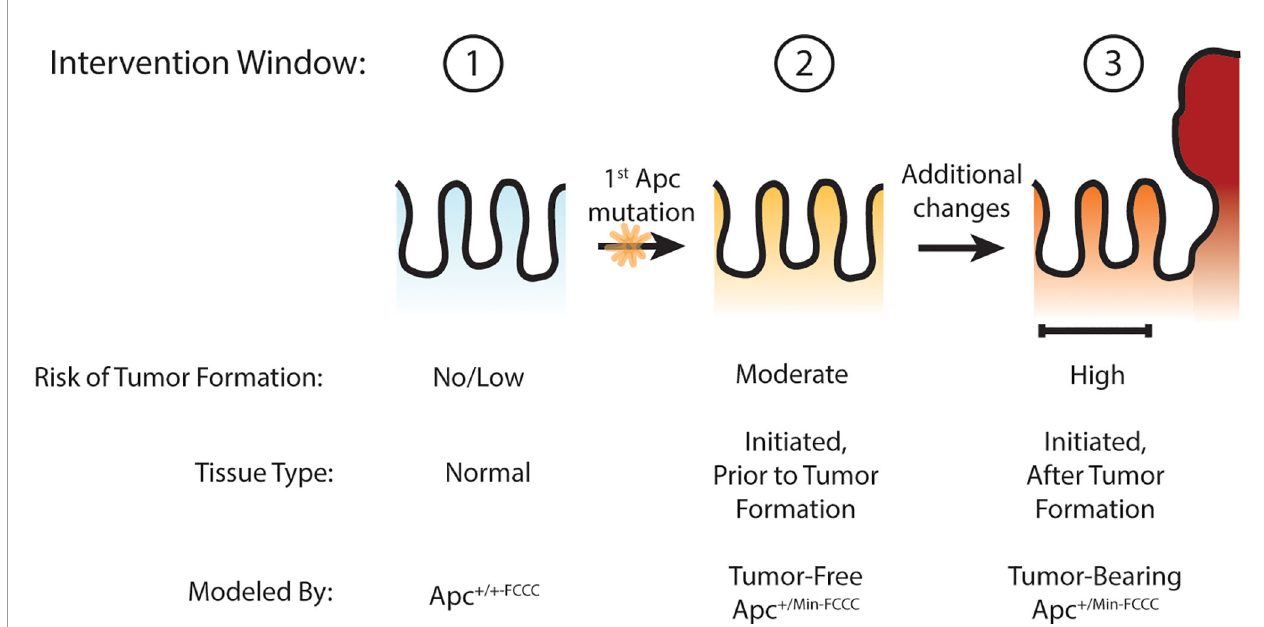
FIGURE 1 | Windows of opportunity for preventive intervention for colon cancer. Three potential windows of opportunity were de fi ned: (1) prior to tissue initiation (Apc mutation); (2) after initiation but prior to adenoma formation; (3) and after formation of the fi rst adenoma. To examine these windows of opportunity, nonneoplastic tissue from mice representing each stage of early tumorigenesis was evaluated and pro-tumorigenic processes were